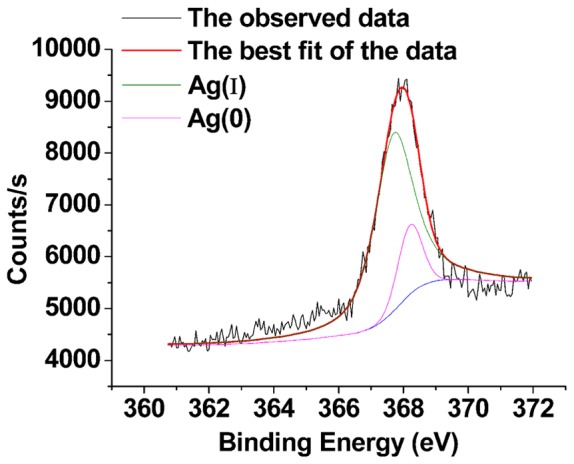
The XPS spectra of Ag (3d5/2) of BMO after absorbing Ag+.The upper black curve represents the observed data. The red curve is the best fit model for the data. The green curve represents the Ag(I) peak, while the pink curve is the Ag(0) peak.